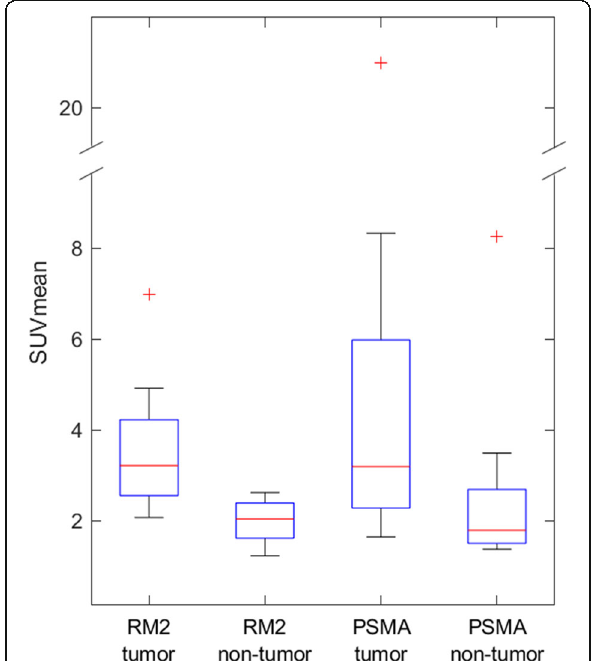
Fig. 2 Boxplots for each patient ’ s [ 68 Ga]Ga-RM2-PET SUVmean of voxels containing tumor in 3D-Histo compared to all voxels not containing tumor (whiskers end at 1.5 times interquartile range, paired t test: p = 0.014). For comparison, the respective values for PSMA-PET are also shown (paired t test: p =